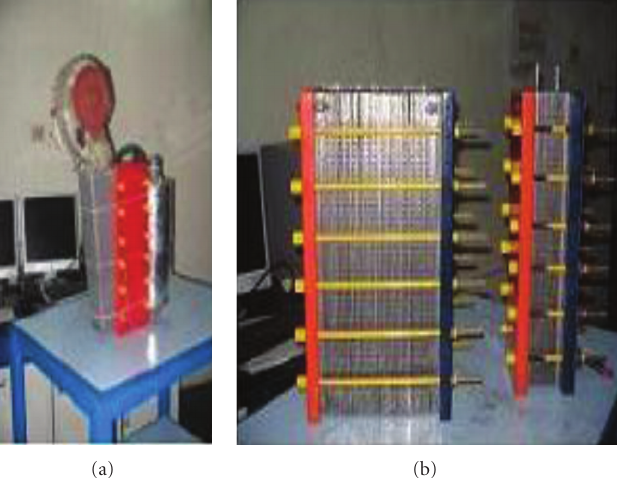
Figure 3: Photograph showing the forced-air breathing